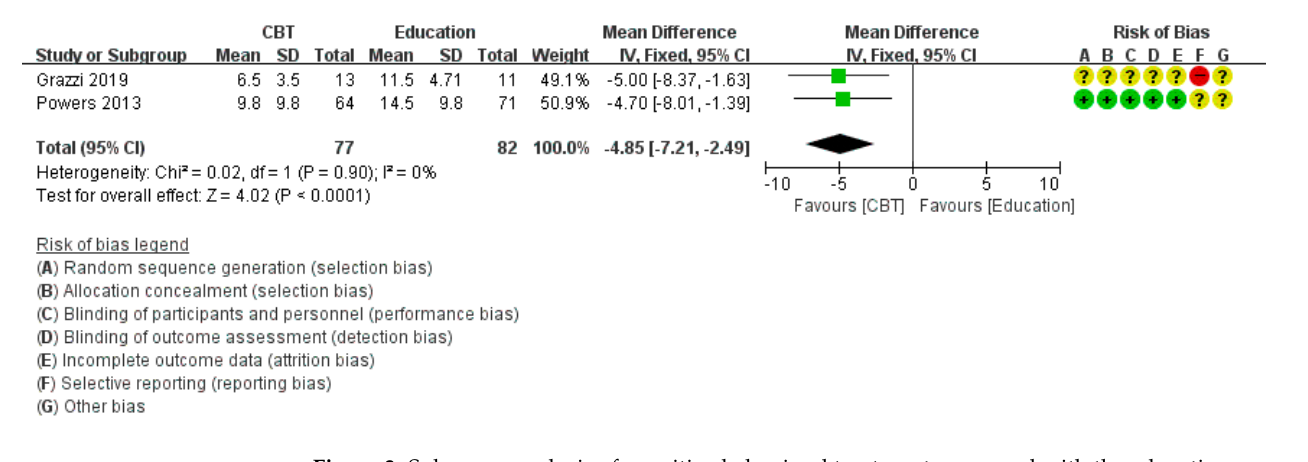
Figure 3. Subgroup analysis of cognitive behavioral treatment compared with the education group regarding the difference from baseline in headache frequency.